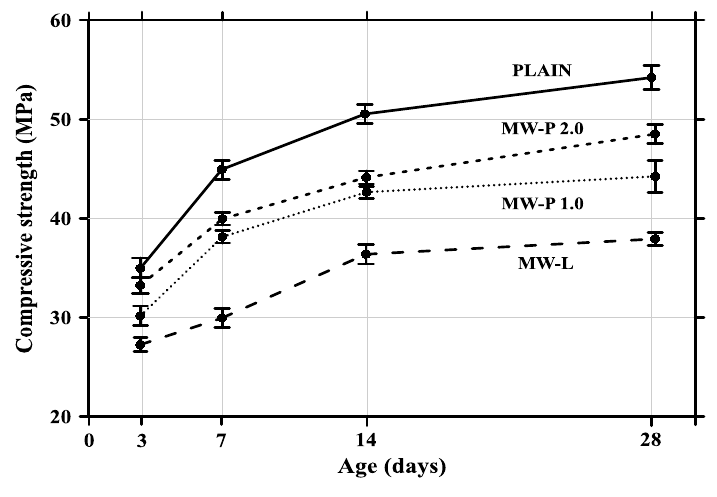
Figure 7. Compressive strength.